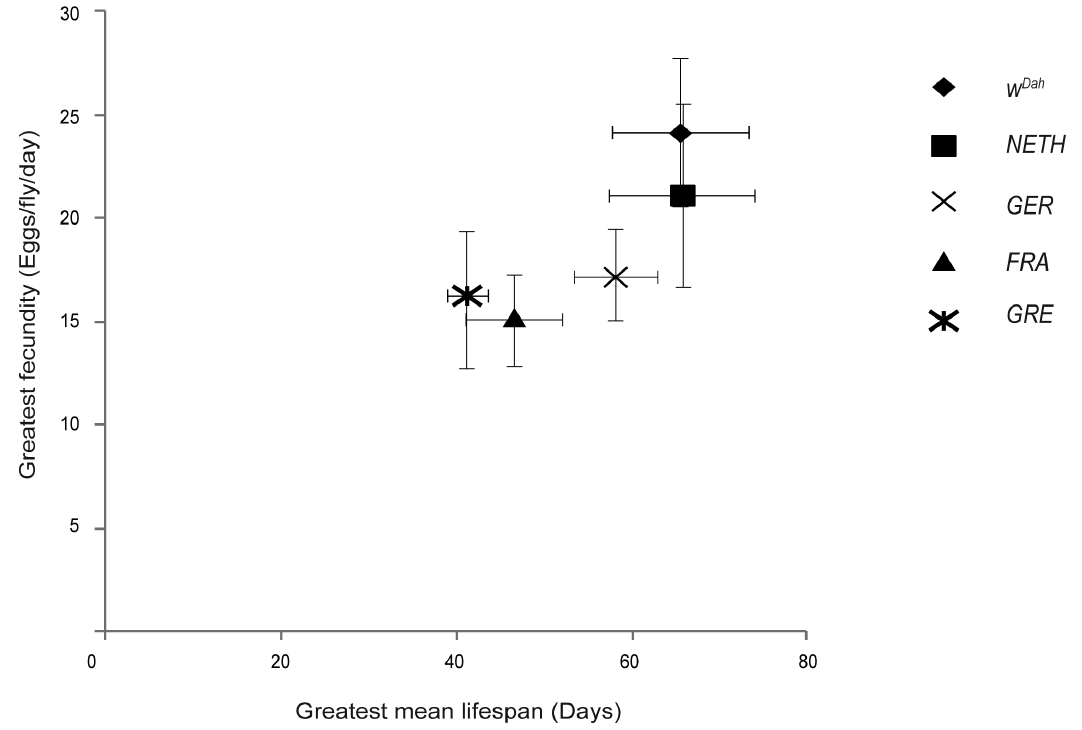
Figure 4. Wild-derived strain NETH had similar greatest mean lifespan/fecundity values to laboratory strain W Dah . Under all food conditions tested in this study, the combined greatest mean lifespan and greatest mean fecundity values were seen in the laboratory-adapted W Dah and wild-derived NETH strains, compared to each of the other strains (for lifespan: p , 0.001, log rank test, for fecundity: p , 0.01, one-way ANOVA with Bonferroni’s Multiple Comparison test). Greatest mean lifespans for GRE , GER and FRA strains were obtained from 0.5 yeast concentration food, while for W Dah and NETH strains from 1.0 yeast concentration. For all strains greatest fecundity occurred at 2.0 yeast concentration food. Wild-derived strain NETH had similar greatest mean lifespan/mean fecundity values to the laboratory strain W Dah (for lifespan: p . 0.05, log rank test, for fecundity: p . 0.05, one-way ANOVA with Bonferroni’s Multiple Comparison test). Data are derived from results shown in Figures 1 and 2. Error bars indicate standard deviation